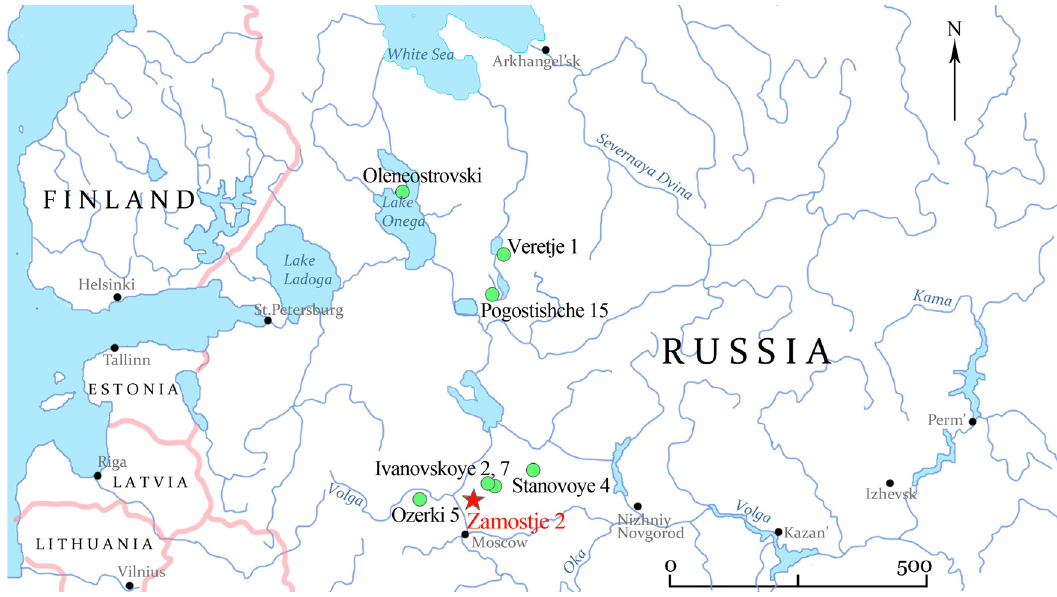
Figure 1: Location of Zamostje